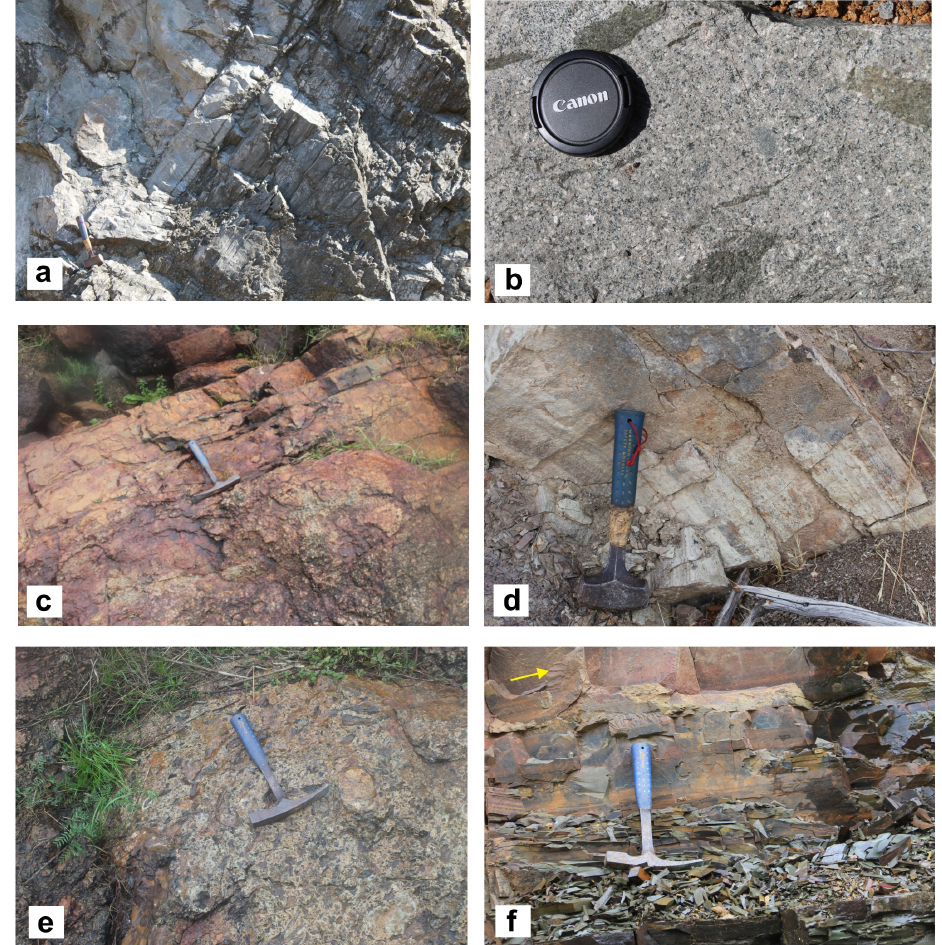
Figure 3. Photographs of the Carboniferous igneous rocks of the Santa Susana–São Cristovão region: (a) Baleizão porphyry intrusive contact (yellow arrow) with siliciclastic rocks of the Toca da Moura volcano-sedimentary complex; (b) Baleizão porphyry; (c, d) rhyolitic tuffs of the Toca da Moura volcano-sedimentary complex; (e) volcanic breccia with fragments of siltstone (black) and rhyolite (yellow) at the base of the silicic tuffs of the Toca da Moura volcano-sedimentary complex; and (f) silicic volcanic rock interbedded with siltstones of the Cabrela volcano-sedimentary